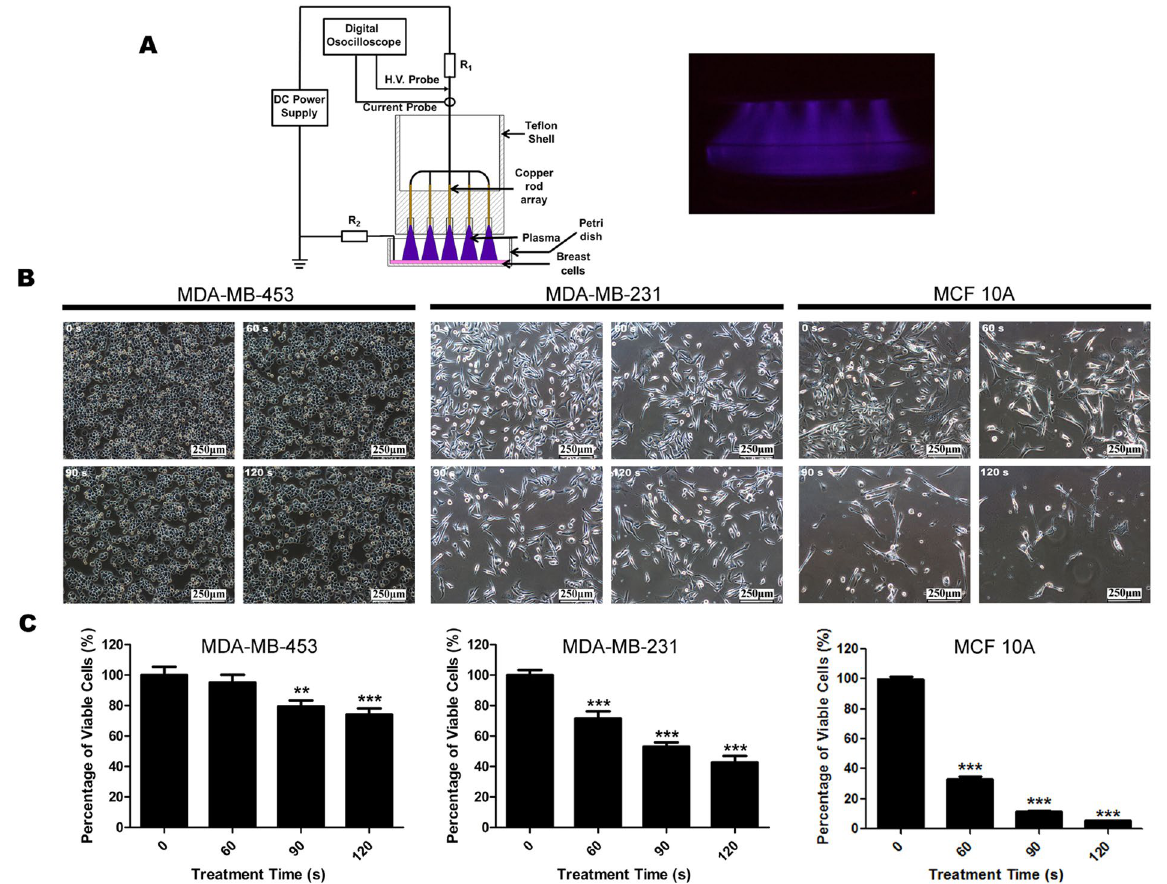
Figure 1. NTP treatment reduces proliferation of MDA-MB-453, MDA-MB-231 and MCF10A cells in a time dose dependent inhibition. ( A ) Schematic of the non-thermal atmospheric plasma set-up utilised in this study, and a photograph of the air plasma. All cells were exposed to NTP for 0, 60, 90 or 120 s. Forty-eight hours later, cell images were captured with 100 × magnification ( B ) and cell numbers of each dish were counted by an automatic analyzer CountStar ( C ). All experiments were replicated a minimum of three times. Data are presented as means ± S.D. and statistical analysis was carried out using one-way ANOVA with Tukey’s multiple comparison test ( * p < 0.05, ** p < 0.01, *** p < 0.001 versus